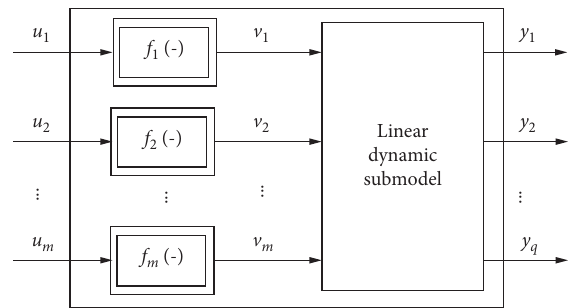
Figure 1: Multivariable Hammerstein model